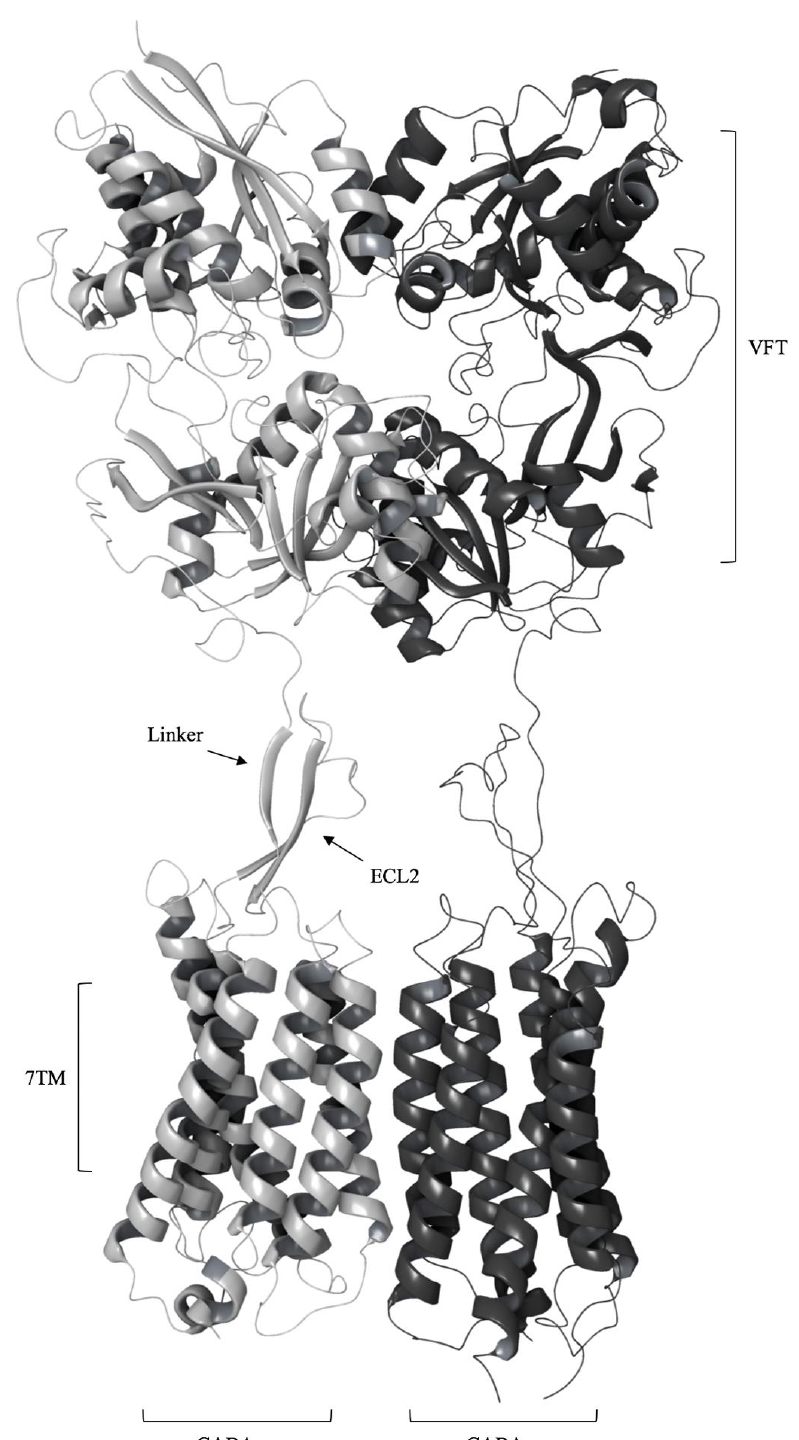
Figure 1. A schematic representation of the (GABA) type B receptor (GABA B -R) heterodimer with the extracellular Venus Flytrap domain (VFT) and the heptahelical transmembrane domain (7TM) of the GABA B1b (gray) and GABA B2 (black) protomers. The VFT is connected to the 7TM by a linker that interacts with the extracellular loop 2 (ECL2) of 7TMs (active receptor conformation (Protein Data Bank (PDB) ID: 6OU8).